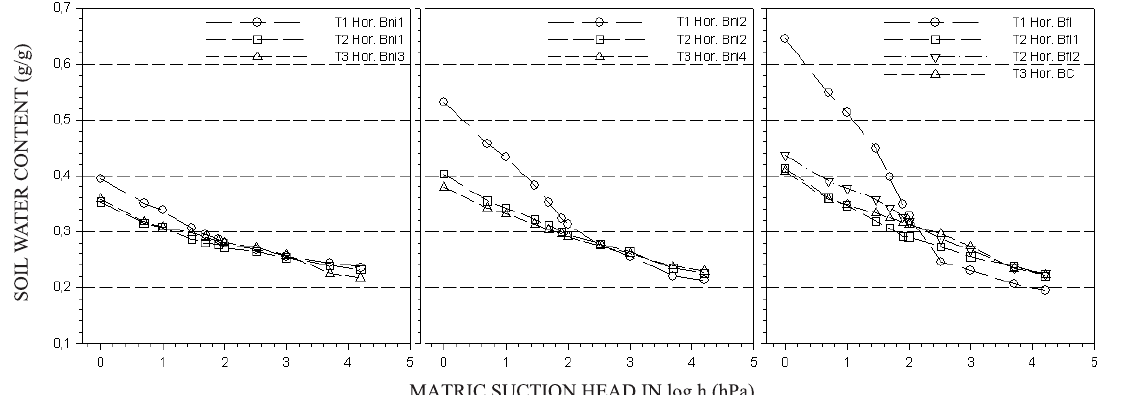
Figure 6. Comparison between the soil water characteristic curves of the Bni and Bfl horizons situated in different positions on the